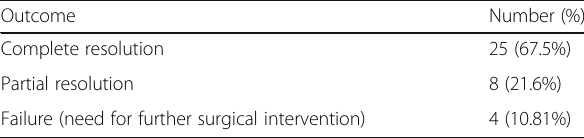
Table 3 Outcome of multiloculated pleural infection after treatment with medical thoracoscopy in the studied patients (